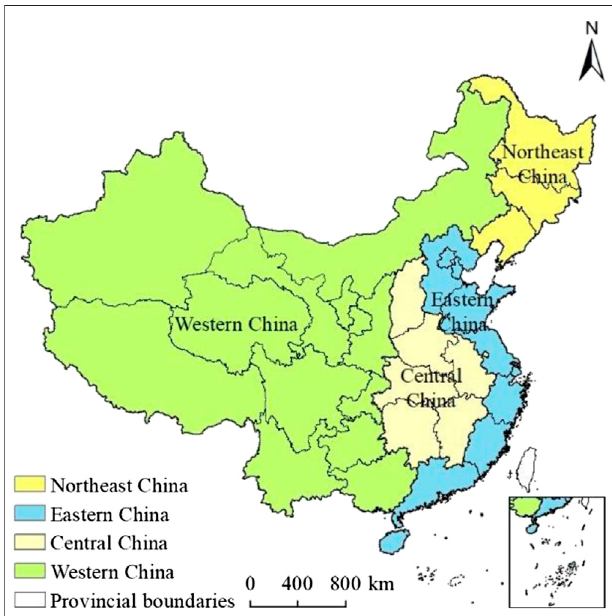
FIGURE 1 | China ’ s four major economic